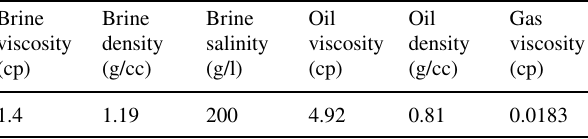
Table 2 Fluid properties used in the core-flood tests (water-flooding and gas injection) at a temperature of 25 °C Brine viscosity